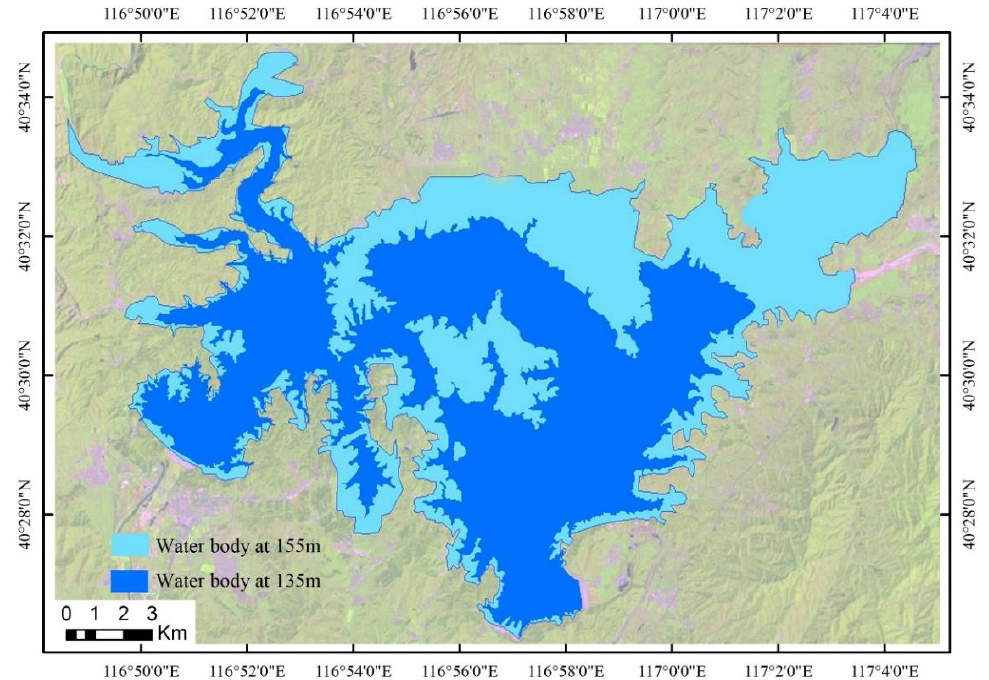
Figure 2. The growth of the water body after the SNWTS.